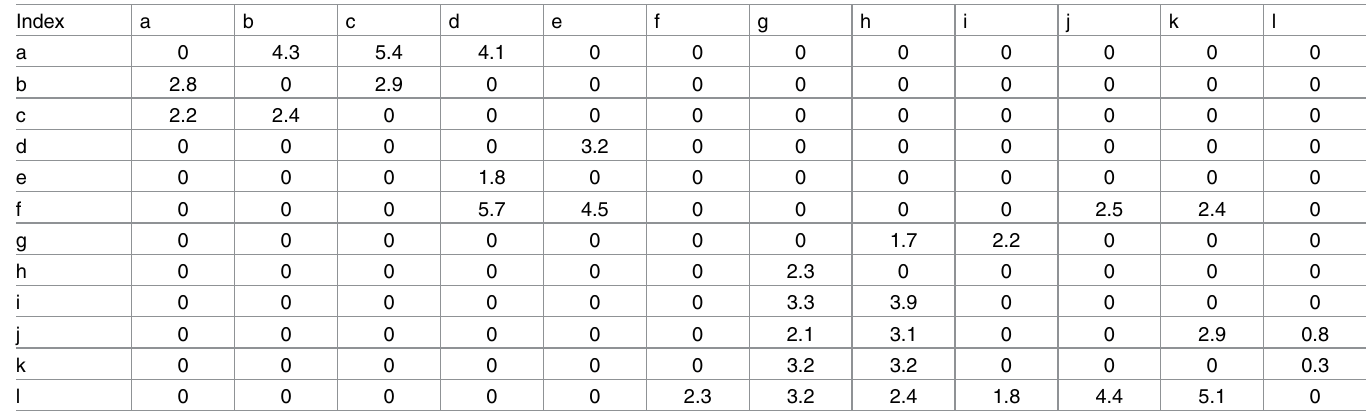
Table 2. Initial direct-relation matrix X